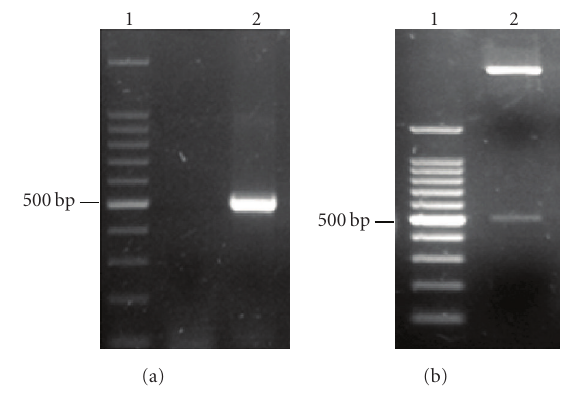
Figure 2: Construction of prokaryotic expression vector pET- VEGI-CTT. (a) DNA fragments of VEGI-CTT were amplified by PCR. Lane 1: 100 bp markers. Lane 2: VEGI-CTT fragment of 486bp. (b) Restriction enzyme analysis of the prokaryotic expression vector pET-VEGI-CTT. Lane 1: 100 bp markers; lane 2: pET-VEGI-CTT digested by Xba I and Xho I.